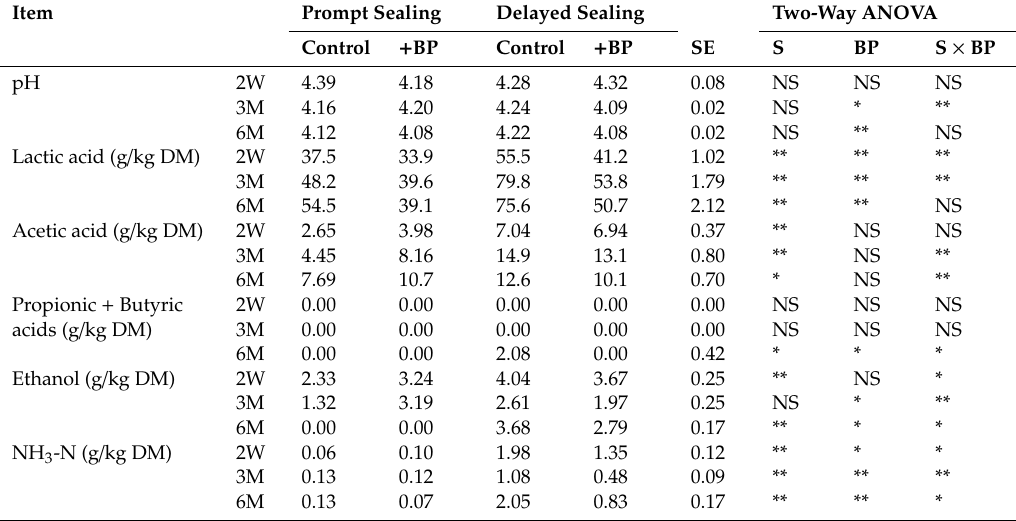
Table 2. Composition of fermentation products of factory 1 soybean curd residue silage prepared with prompt and delayed sealing (S) and with and without beet pulp (BP)